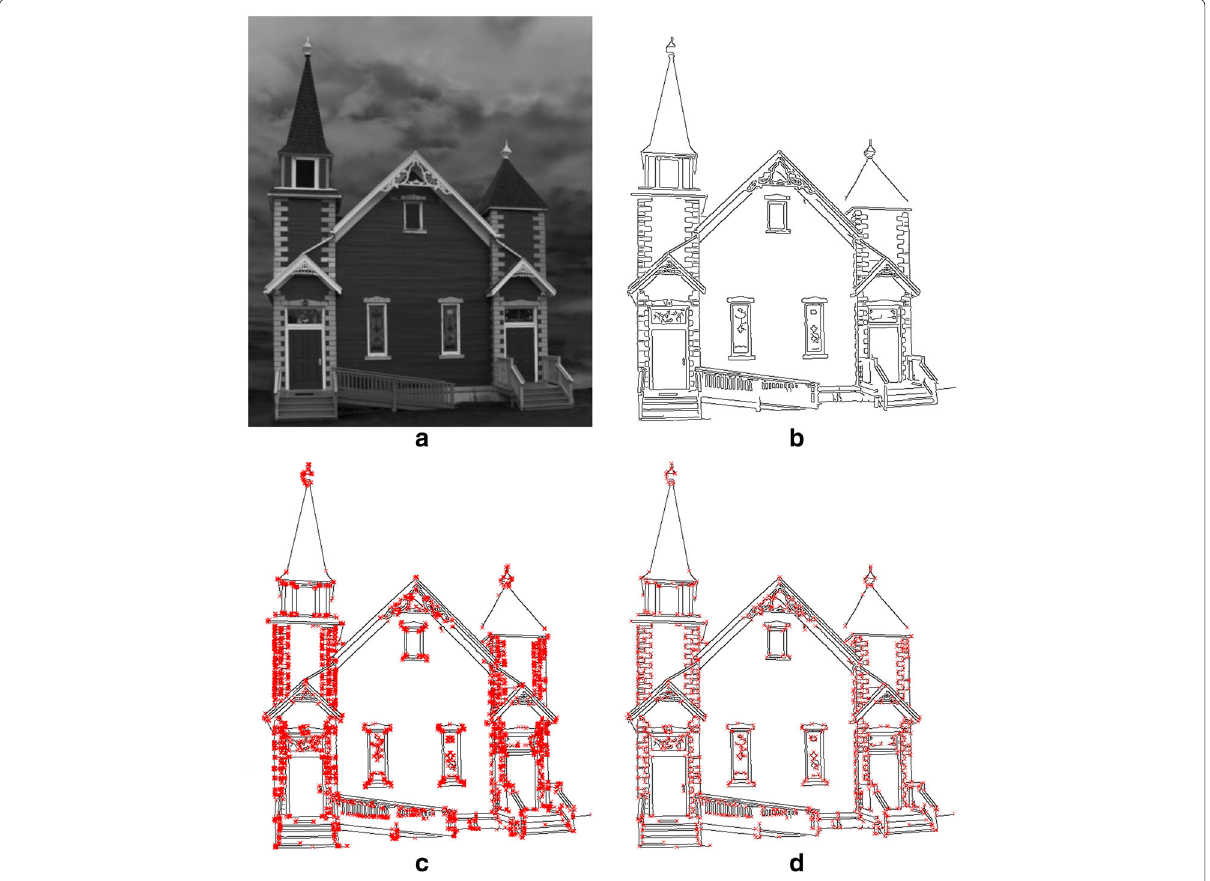
Fig. 7 Result of segment endpoint detection. a Original image. b Canny image. c Initial image positions of detected segment endpoints obtained from their positions in the 3D Hough space. d Final segment endpoint positions in the image